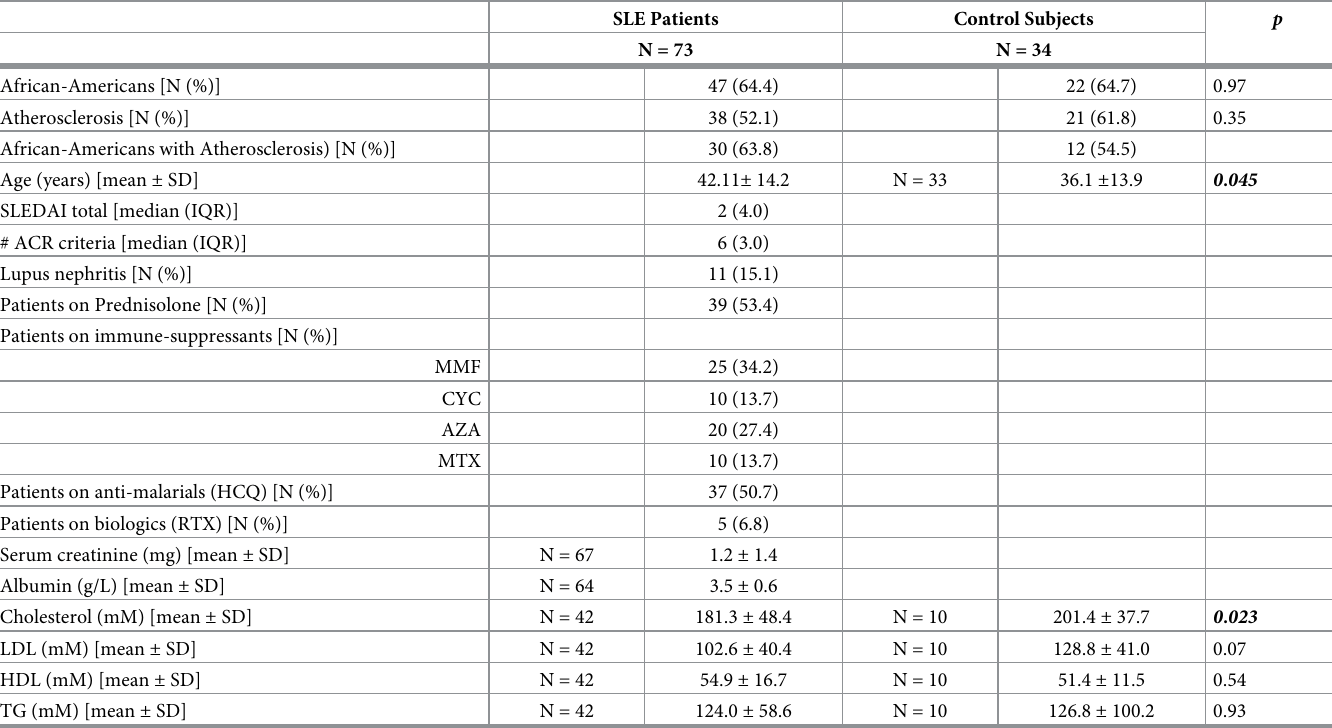
Table 1. Demographic and clinical characteristics of study